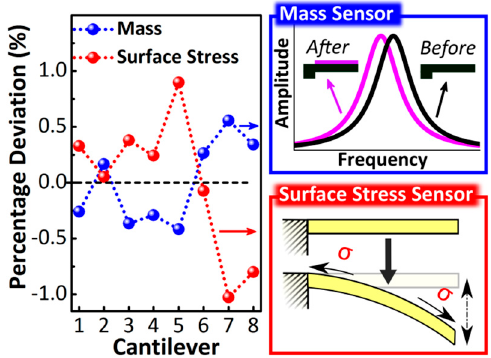
Figure 5. Percentage deviation of the mass and surface-stress sensitivities with respect to their average values for each of the eight measured cantilevers. (Top right blue box) Schematics of the effect of the mass loading on the resonance frequency of a cantilever; the resulting downshift of the resonance frequency is proportional to the added mass. Mass sensitivity was evaluated by calculating the resonance frequency shift produced by the addition of a uniform mass layer deposited on the top cantilever surface. (Bottom right red box) Schematics of the effect of the surface stress on the out-of-plane displacement of a cantilever; the cantilever displacement is proportional to the surface stress applied. Surface stress sensitivity was evaluated by calculating the displacement of the free cantilever end induced by a uniform and isotropic surface stress exerted on the upper cantilever surface.